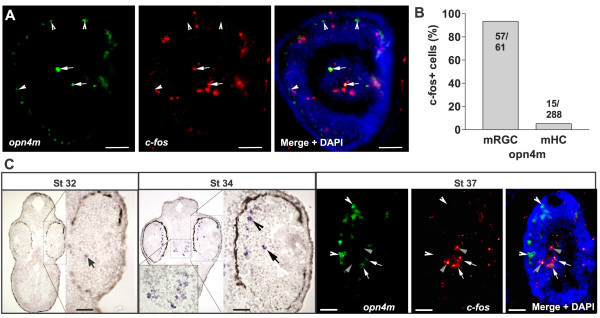
Light induces c-fos expression in melanopsin-expressing retinal ganglion cell (mRGCs) but not melanopsin-expressing horizontal cells (mHCs) as early as Stage 37/38. (A) Double in situ hybridization against opn4m and c-fos on a transverse retinal section from a Stage 42 embryo. Merged image with DAPI staining is also shown. (B) Quantification of the number of c-fos + cells that also express opn4m in the RGC layer (mRGCs) and in the INL (mHCs) expressed as percentages. The number of cells counted is indicated. (C)In situ hybridization against opn4m (Stage 32 and 33/34) (left panels) and double in situ hybridization against opn4m and c-fos (Stage 37/38) (right panels). Left: Transverse sections through the peripheral eye (higher magnification Stage 32 and 33/34) and the brain (Stage 33/34) are shown. mHCs (opn4m+ / c-fos−; arrowhead), mRGCs (opn4m+ / c-fos+; arrow) and RGCs (opn4m− / c-fos+; gray arrowhead) are indicated. Scale bar = 50 μm.